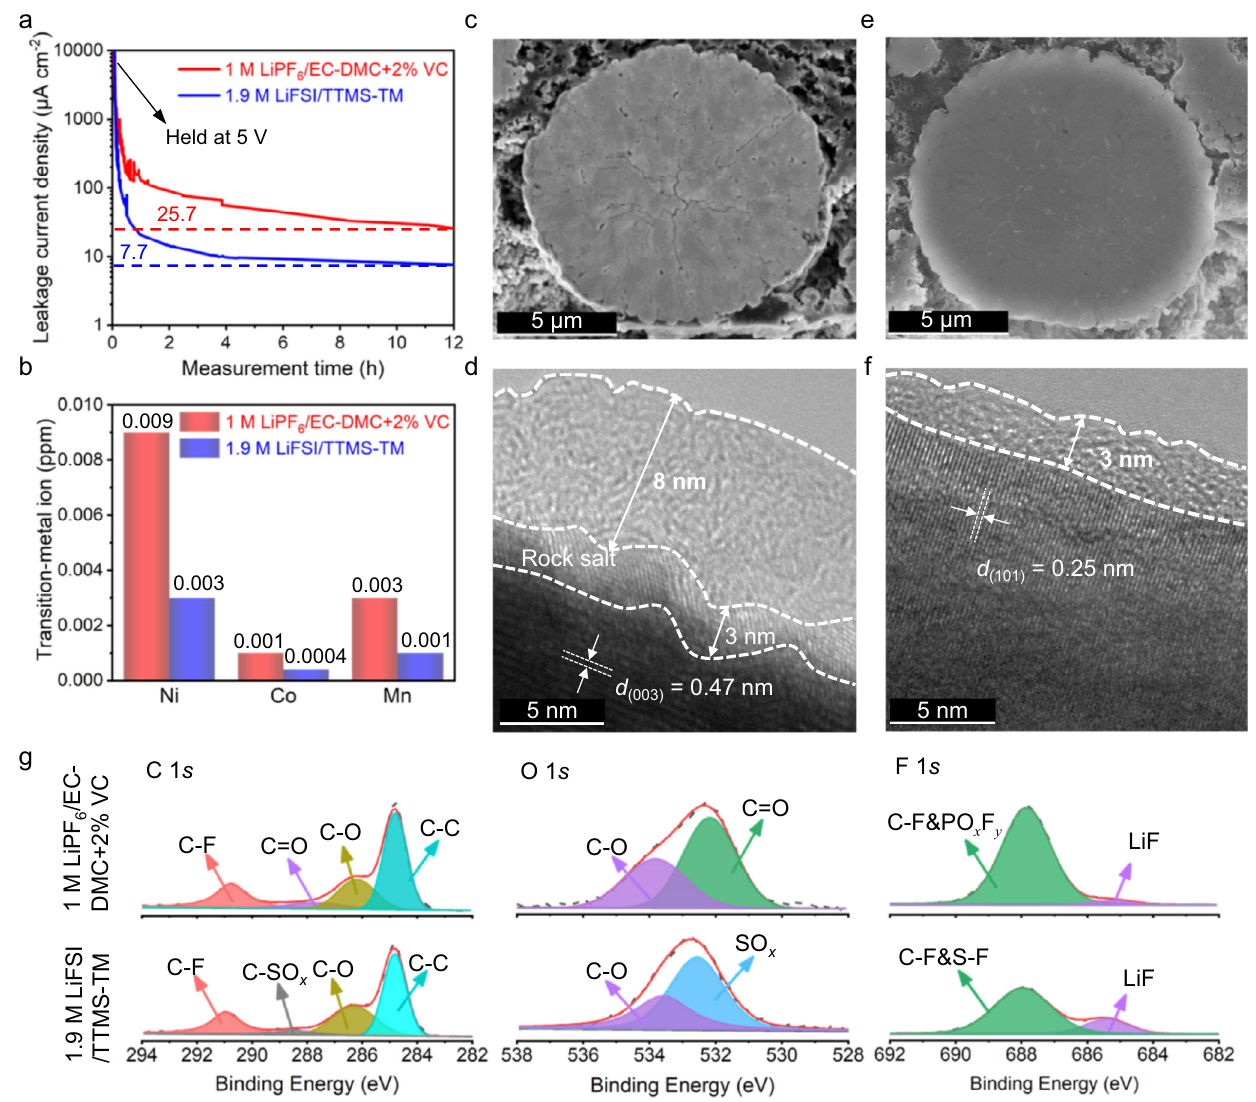
Fig.3|Oxidationstabilityofthedesignedelectrolyteandinterfacialchemistry of the NCM811 cathodes retrieved from the cycled full cells. a Leakage current density during a constant-voltage (5V vs . Li + /Li) fl oating test of the NCM811 cath- odes after3 cyclesinthe indicated electrolyte. b Transition-metal(Ni,Co, and Mn) dissolution determined by inductively coupled plasma mass spectrometry (ICP- MS) after 100 cycles in the indicated electrolyte. c , d Cross-sectioned SEM images